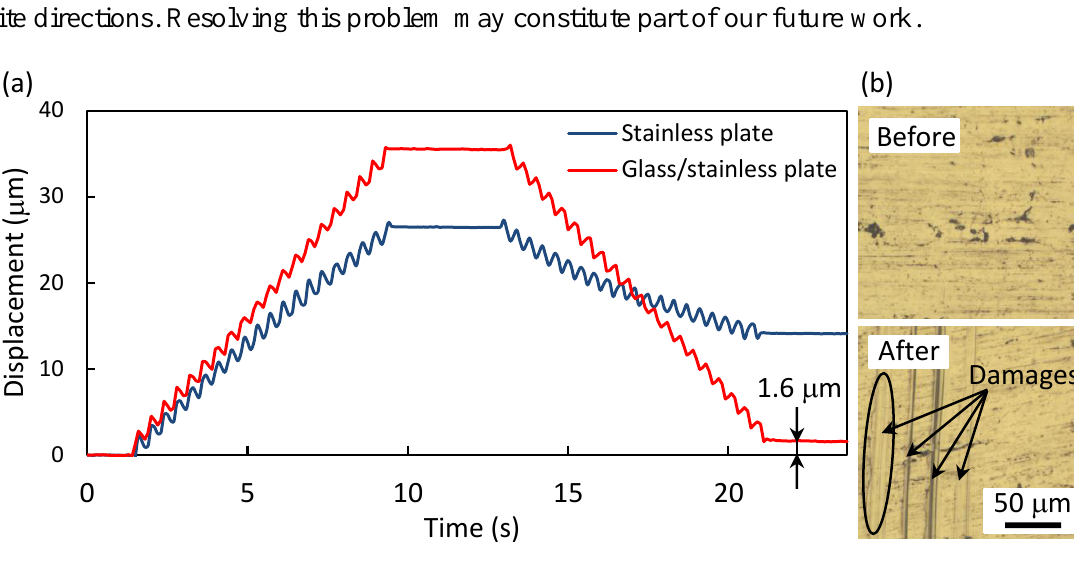
Figure 6. ( a ) The continuous displacements of the central Al cuboid over forty cycles of reciprocating motion on the stainless and glass/stainless plates. ( b ) Optical images of the surface of the stainless plate before and after the several cycles of